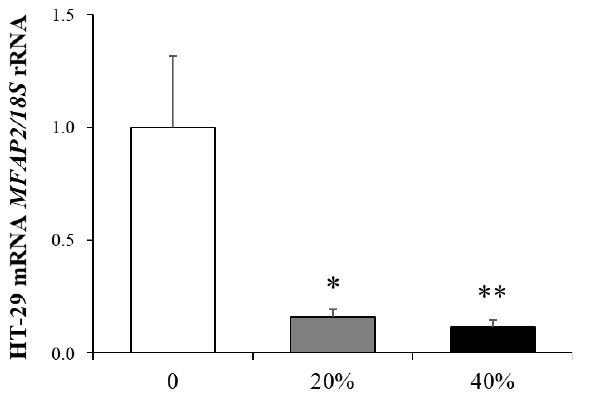
Figure 4. Bar graphs show the effect of ACM (20% and 40%) from obese subjects on the transcript levels of MFAP2 in HT-29 cells. Values are the mean ± SEM ( n = 6 per group). Differences between groups were analyzed by one-way ANOVA. * p < 0.05 and ** p < 0.01 vs. unstimulated cells.